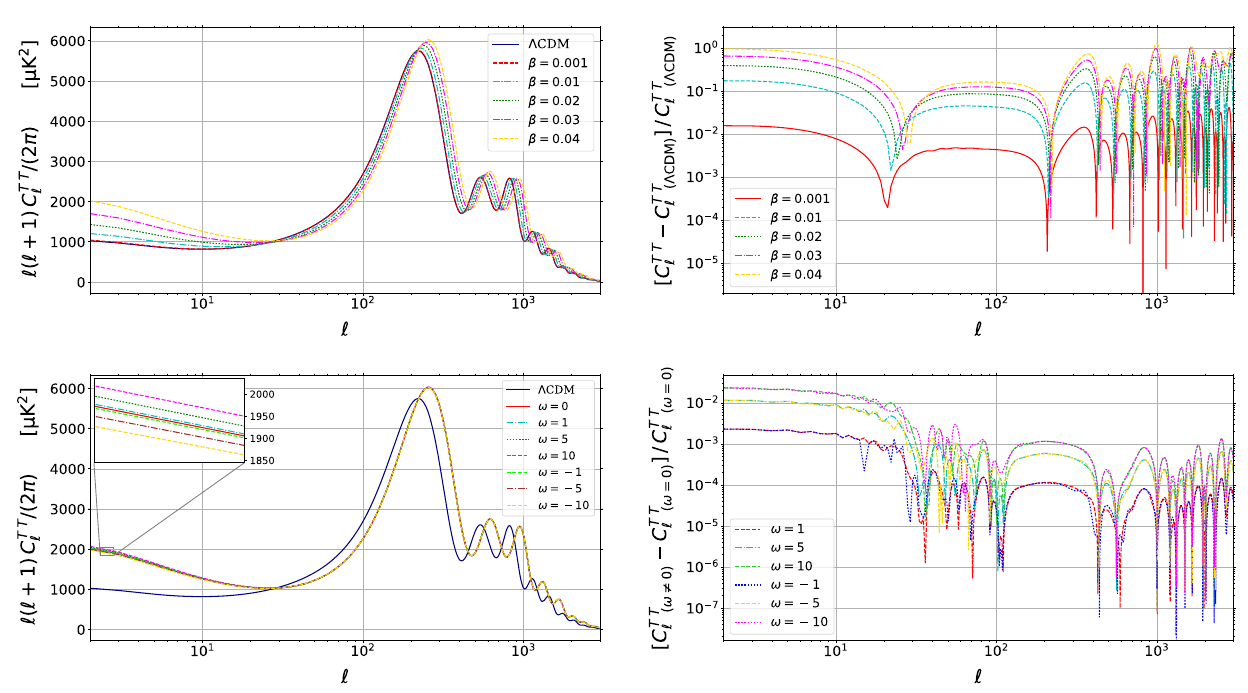
Fig. 1 Upper panels show the CMB power spectra diagrams (left) and their relative ratio with respect to standard cosmological model (right) for different values of β , considering ω = 0. Lower panels show the